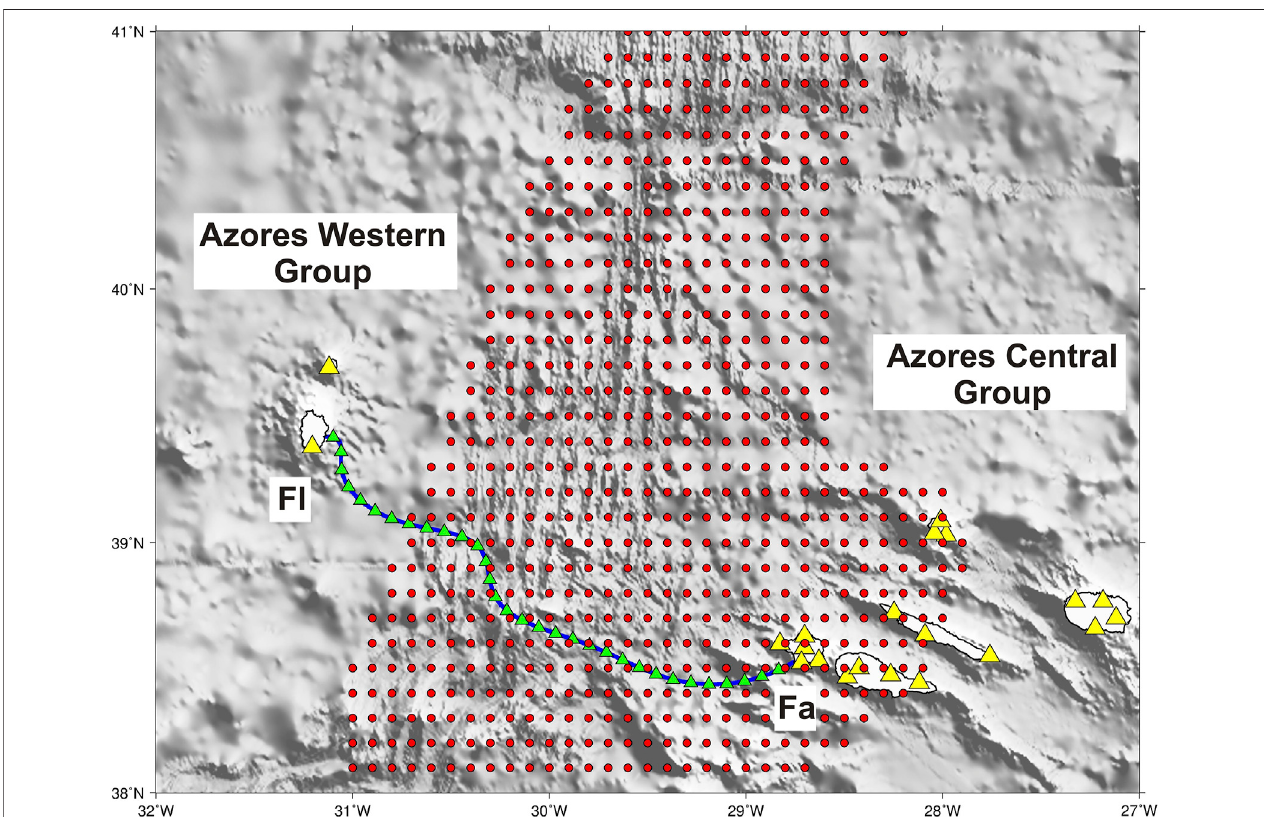
FIGURE 5 | Layout of sensors and sources for the investigation of the LI contribution to the monitoring of earthquakes in the Azores. Red dots show the epicenter syntheticlocations,aregulargridwith0.1 ° interval.TheyellowtrianglesonlandshowtheexistingseismicstationsoperatedbyIPMA.Bluelineisthepresumedlocationof the Faial-Flores submarine cable, along which the green triangles show the virtual seismic stations spaced every 8 km. Fl – Flores Island, Fa – Faial Island.